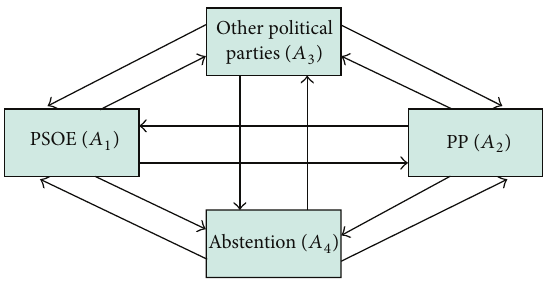
Figure 2: Model flow graph. Graphic representation of the people flow among the